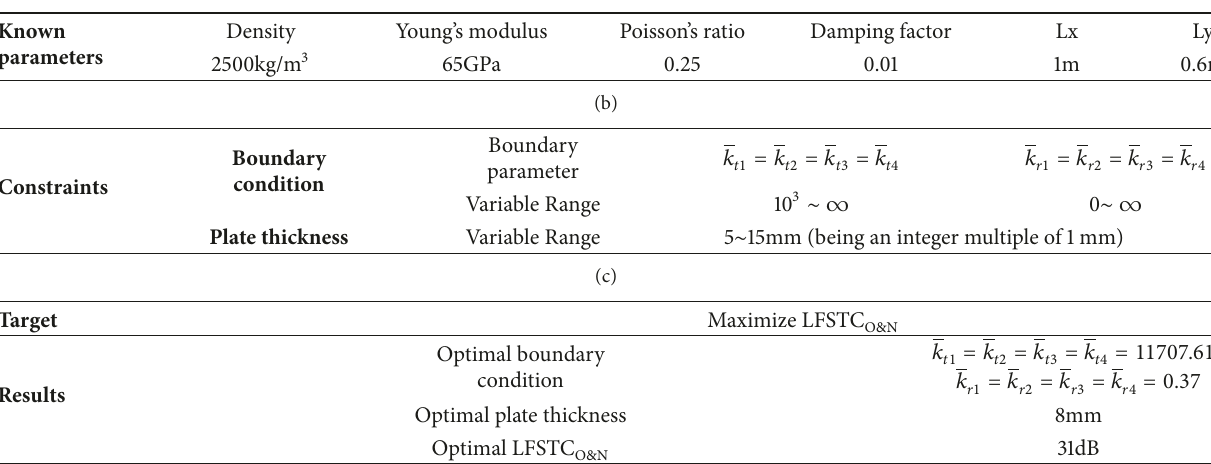
Table 3: Known parameters and optimization of Case 2.